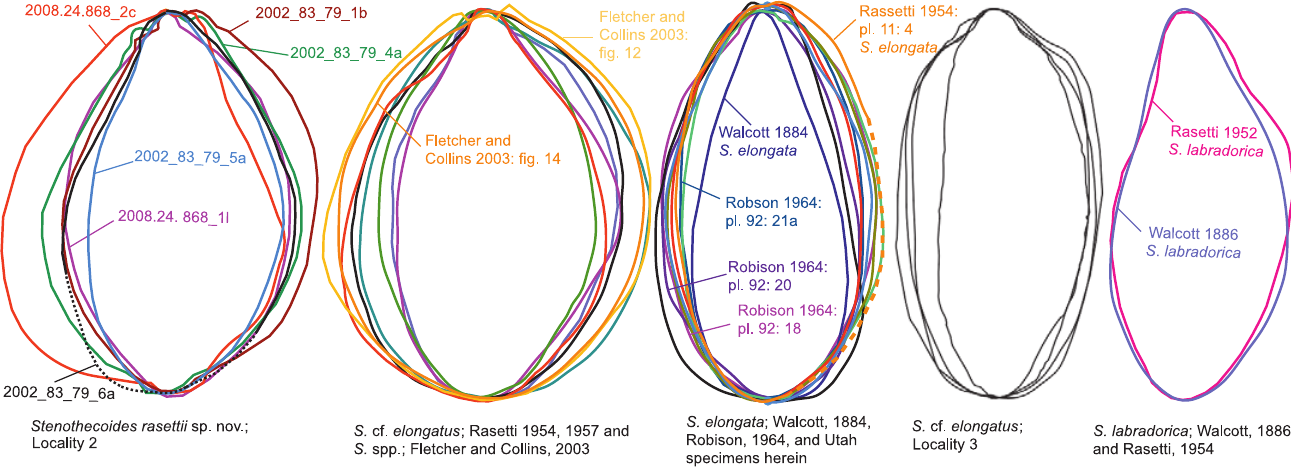
Fig. 10. Shell outlines of species discussed (Fig. 5E ), but in most, the posteriormost margin of the valve 1